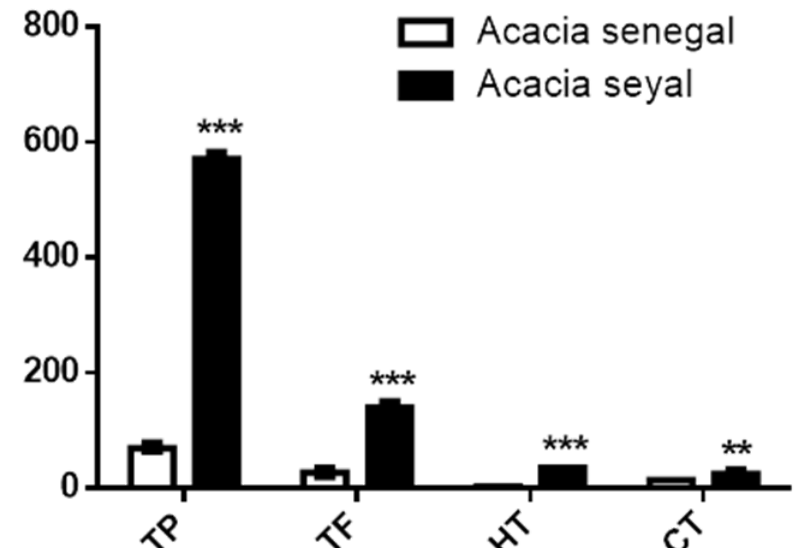
Figure 2. Phytochemical content of A. senegal and A. seyal . TP: Total phenols (exprimed in mg GAE / g; TF: Total flavonoids (exprimed in mg RTE / g); HT: Hydrolysable tannins; CT: Condensed tannins (exprimed in %). ** indicates statistically significant di ff erence in values ( p < 0.01); *** indicates statistically significant di ff erence in values ( p < 0.001).